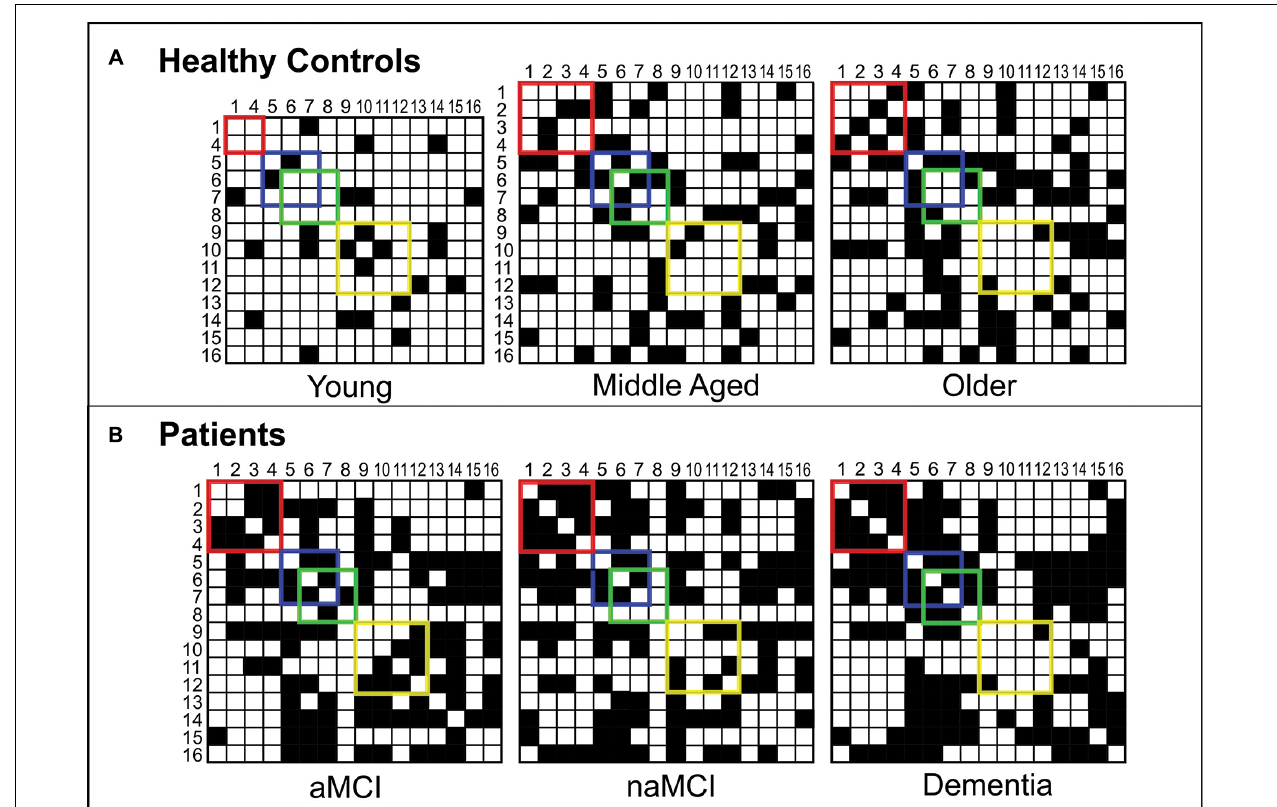
FIGURE 2 | Binary adjacency matrices for participant groups. Panel (A) shows the binary adjacency matrices of healthy controls (Young, Middle Aged and Older groups). Panel (B) shows the binary adjacency matrices of patients (aMCI, naMCI and dementia groups). A grid square filled in black represents a significant positive correlation (an edge) between two cognitive tests (nodes). Correlations between memory tests are enclosed by the red square, abstract reasoning by the blue square, semantic processing by the green square and executive functions by the yellow square. For ease, cognitive tests have been converted to numbers so that: 1 = Rey-Osterrieth Complex Figure – Recall, 2 = Prose Memory Test – Immediate Recall, 3 = Prose Memory Test – Delayed Recall, 4 = Verbal Paired Associates Learning Test (WMS), 5 = Raven’s Progressive Matrices, 6 = Similarities (WAIS), 7 = Category Fluency Test, 8 = Confrontation Naming Test, 9 = Letter Fluency Test, 10 = Stroop Test – Time Interference, 11 = Stroop Test – Error Interference, 12 = Digit Span Test – Backward, 13 = Digit Span Test – Forward, 14 = Digit Cancelation Test, 15 = Rey-Osterrieth Complex Figure – Copy, 16 = Token